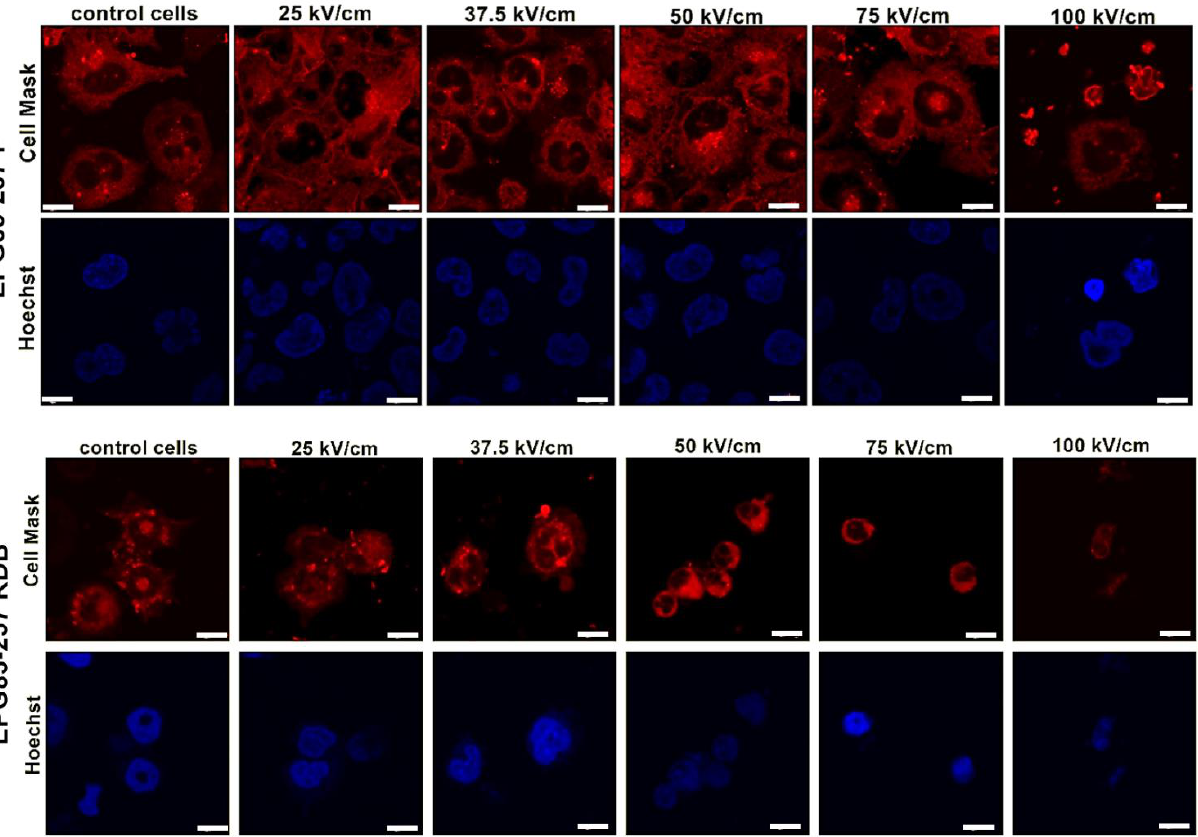
Figure 3. The evaluation of nsPEFs impact on the cell membrane morphology in EPG85-257 P and RDB cells by CLSM imaging, nuclei stained in blue color with DAPI, and cell membranes stained with CellMask Deep Red plasma marker. Scale bars correspond to 10 µm.